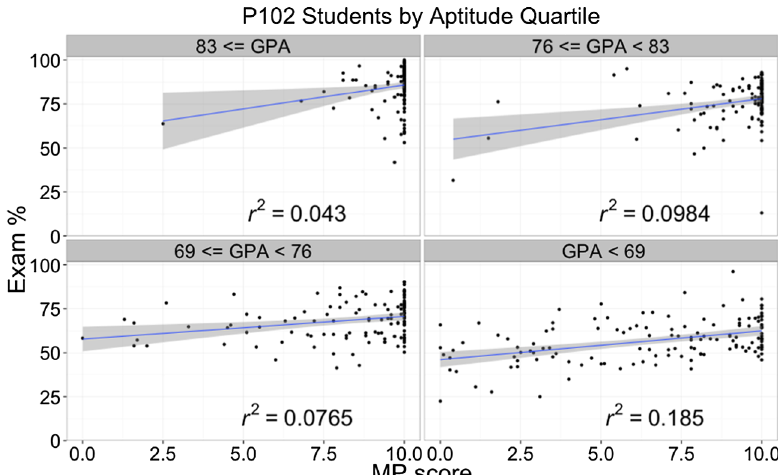
FIG. 2. Correlation between exam performance and homework score for students in a calculus-based introductory electricity and magnetism course P102 grouped into quartiles by aptitude. Top left, high aptitude (GPA ≥ 83 ); Top right, medium-high aptitude (GPA 76 – 83); bottom left, medium aptitude (GPA 69 – 76); bottom right, low aptitude (GPA < 69 ). Shaded areas indicate 95% confidence